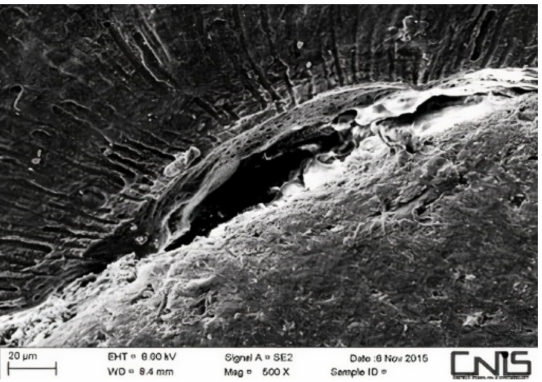
Figure 5. Interface between dentin and sealant. Section of second medium third T.